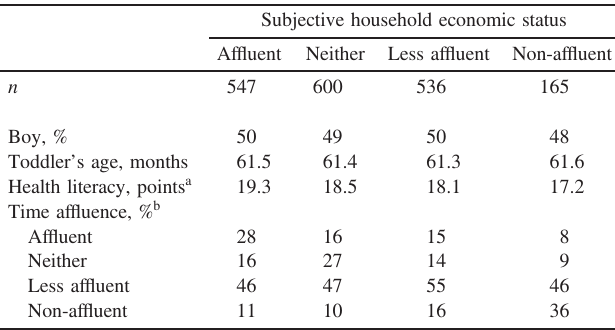
Table 1. Characteristics according to subjective household economic status ( n = 1,848)